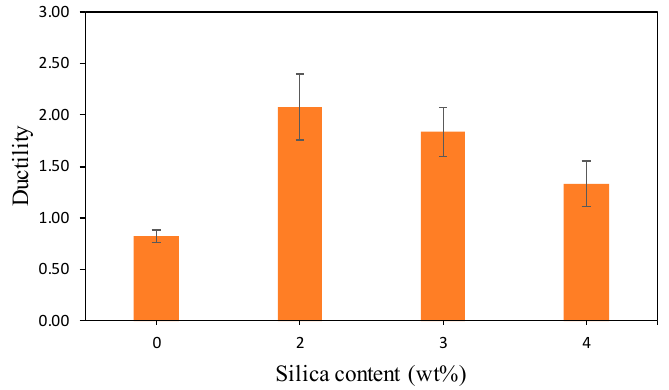
Figure 6. Ductility geopolymer cement with nanosilica.